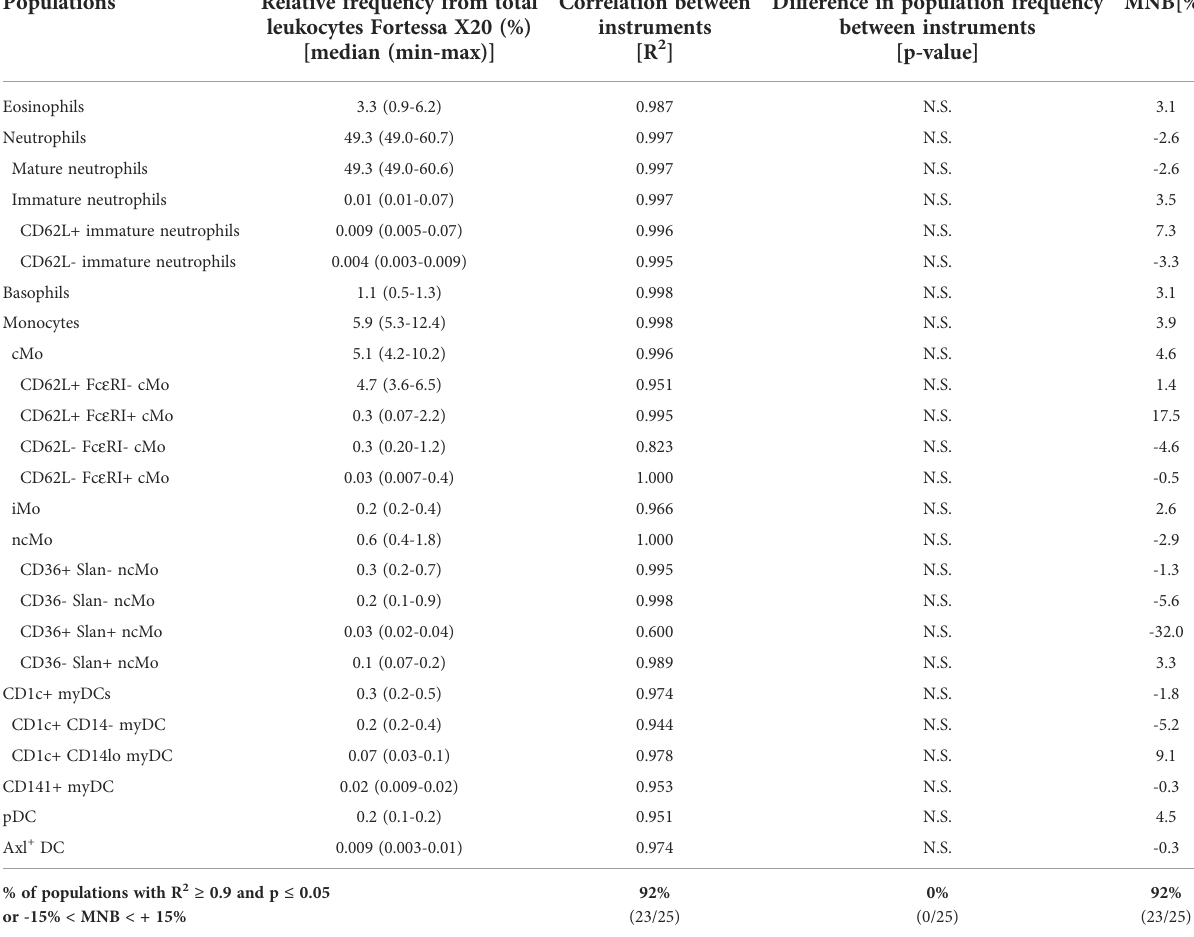
TABLE 2 Comparative evaluation of the relative frequency of the innate myeloid cell (IMC) (sub)populations identi fi ed with the 14-color version (version 4) of the EuroFlow Innate Myeloid Cell tube in paired samples measured employing two different instruments [Fortessa X20 (BD Biosciences) and Aurora (Cytek)]